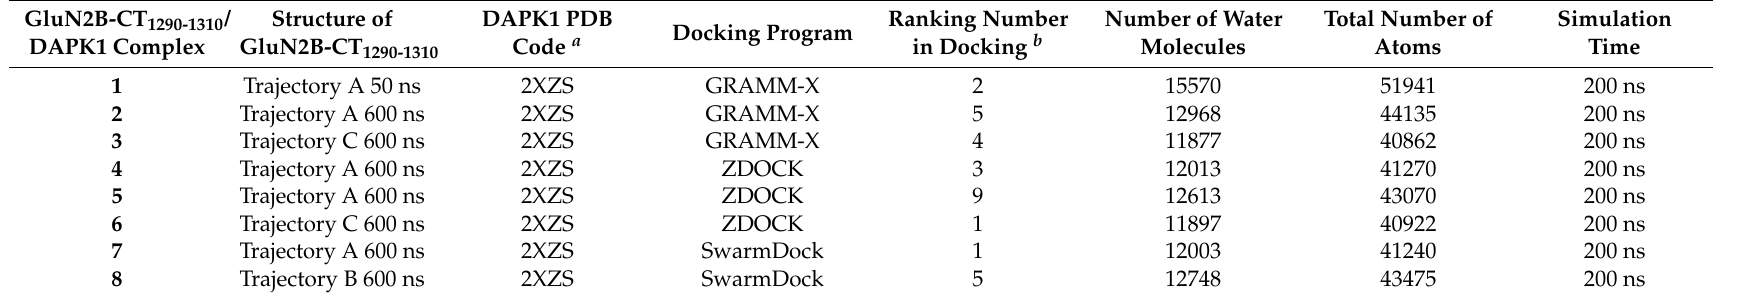
Table 1. Summary of the docking and MD simulations of the predicted GluN2B-CT1290-1310/DAPK1